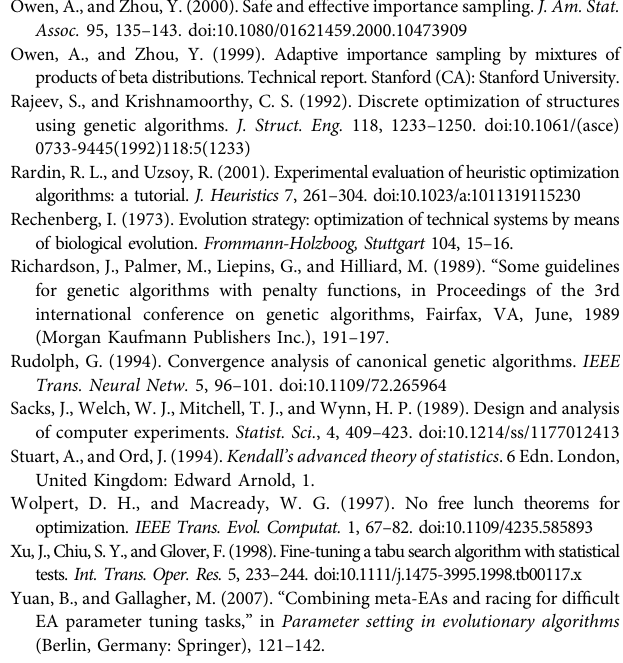
algorithmfordiscreteperformance-baseddesignoptimizationofsteelmomentframes. Comput. Structures 234, 106250.